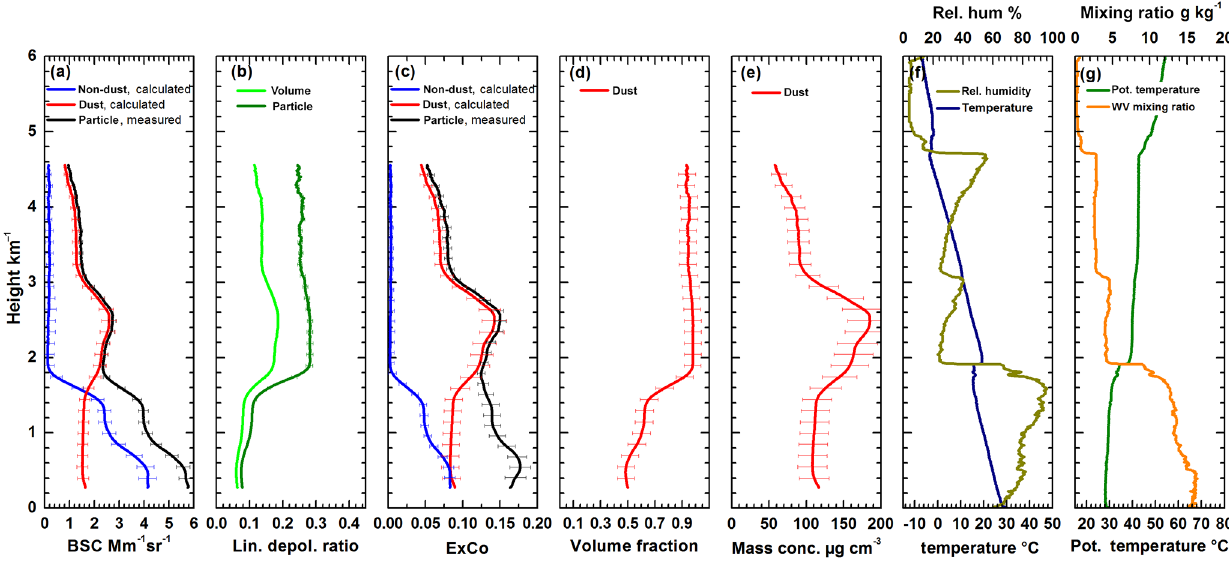
Figure 2. (a) Separation of dust (red) and non-dust (blue) particle backscatter coefficient (BSC) at 532nm from total particle backscatter coefficient (black) at 532nm, (b) measured volume (light green) and particle (dark green) linear depolarization ratio at 532nm, (c) dust (red) and non-dust (blue) extinction coefficient at 532nm and the total particle extinction coefficient (black) at 532nm derived from POLIS lidar measurements, (d) dust volume fraction, (e) dust concentration derived from POLIS measurements at Barbados on 10 July 2013 at 20:00UTC, (f) temperature (dark blue) and relative humidity (dark yellow) profiles, and (g) profiles of potential temperature (dark green) and water vapor mixing ratio (orange) derived from radiosonde measurements started on 10 July 2013 at 17:49UTC. Error bars give the systematical uncertainties resulting from measurement uncertainties and uncertainties in the lidar specific input